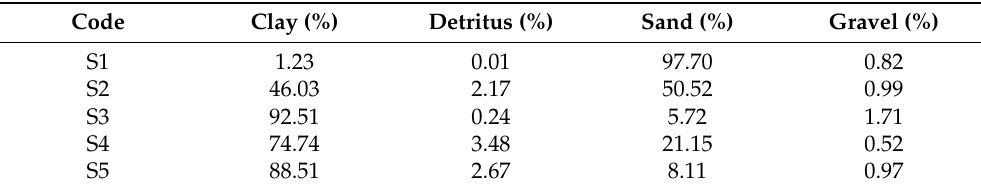
Table 4. Percentage of sediment type in Lake Nokou é and the Cotonou inlet. See Figure 1 for the position of the five sampling